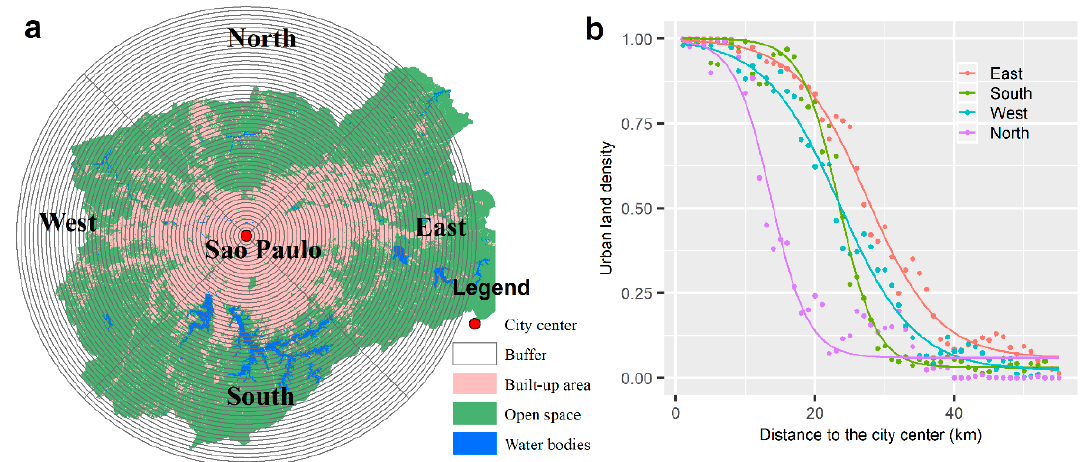
Figure 5. The concentric ring in four directions ( a ) and the spatial attenuation of urban land density in four directions of São Paulo in 2014 ( b ). Table 3. Parameters of inversed-S shape function in four directions of S ã o